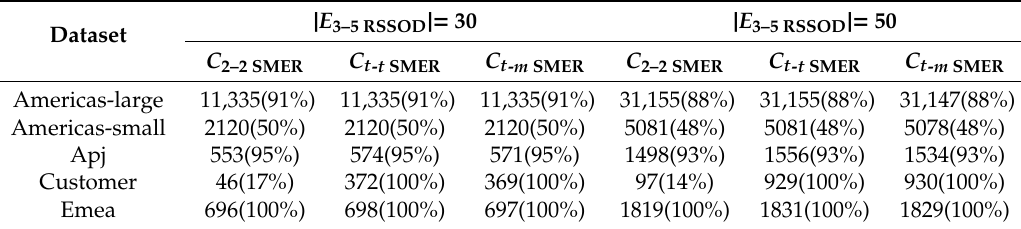
Table 9. Results of SMER constructed from 3–5 RSSOD.